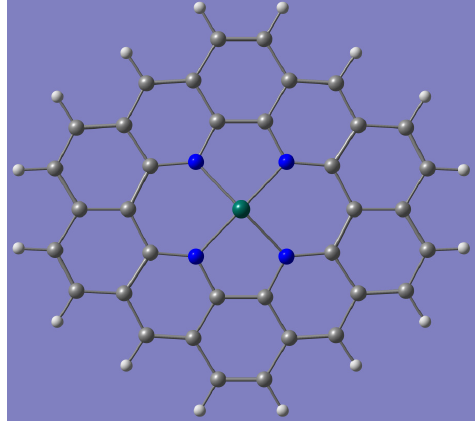
Figure 7. The structure of a model catalyst: graphene doped with four nitrogen atoms and a transition metal. Gray spheres—carbon; blue—nitrogen; white—hydrogen; green—the studied metal (Co, Cu, Ni, Cr, Mn, or Zn).